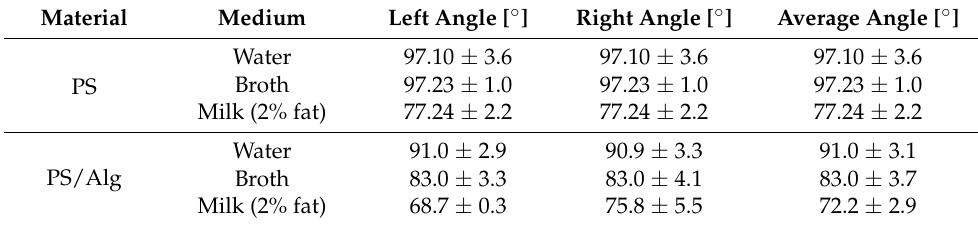
Figure 5. Contact angles of electrospun nanofibers from polystyrene-alginate- L. plantarum 2675 obtained with: ( a ) water; ( b ) MRS broth; ( c ) milk (2% fat). Table 1. Contact angles values of tested materials with selected dietary liquids.